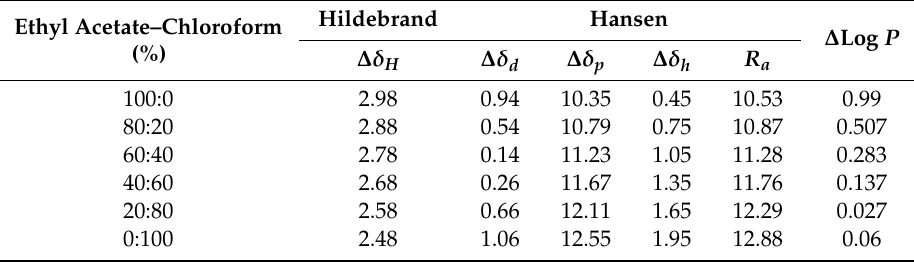
Table 1. Solubility variance of rosmarinic acid in di ff erent solvent systems. Ethyl Acetate–Chloroform (%)